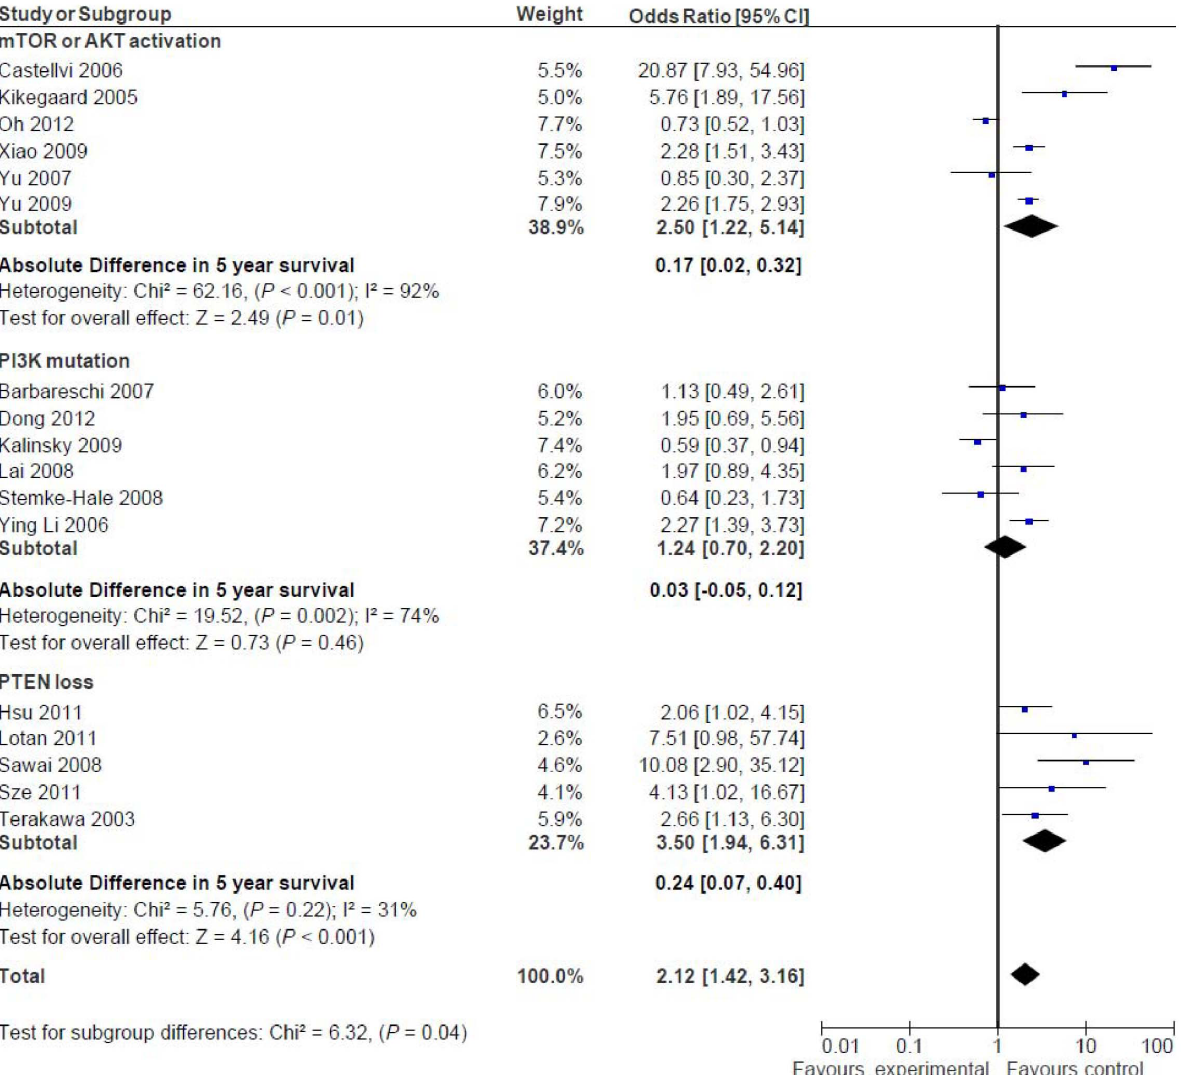
Figure 3. Odds ratio (OR) for 5-year overall survival (OS) according to the expression of different components of the PI3K/mTOR pathway (group subtype). Forest plots of odds ratios for overall survival at 5 years split by subgroups defined by type of activation of the PI3K/ mTOR/AKT pathway. Odds ratios for each trial are represented by the squares, the size of the square represents the weight of the trial in the meta- analysis, and the horizontal line crossing the square represents the 95% confidence interval. The diamonds represent the estimated pooled effect based for each cohort individually (labeled subtotal) and for all cohorts together (labeled total).